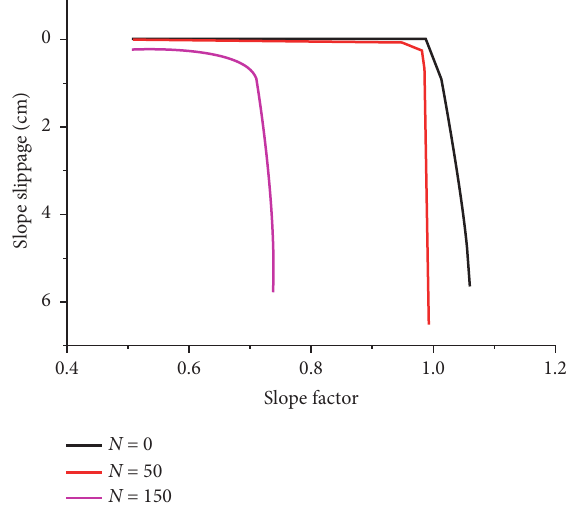
Figure 13: Safety factor of the slope.